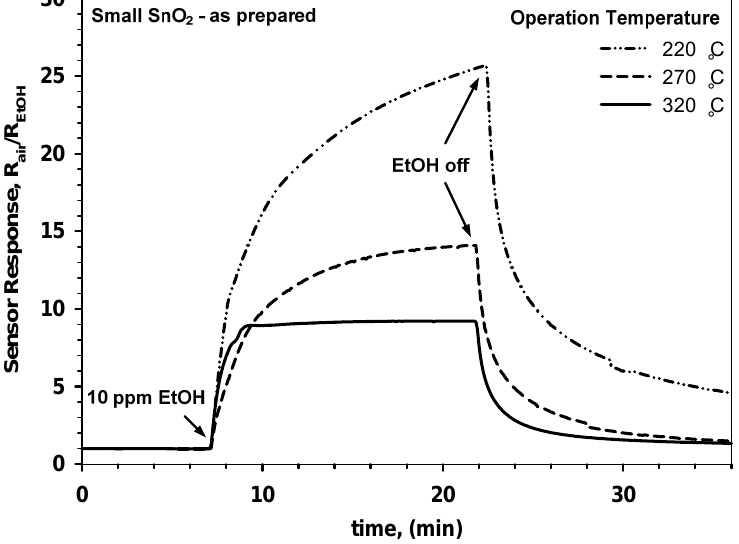
nanocrystals to ethanol without 2